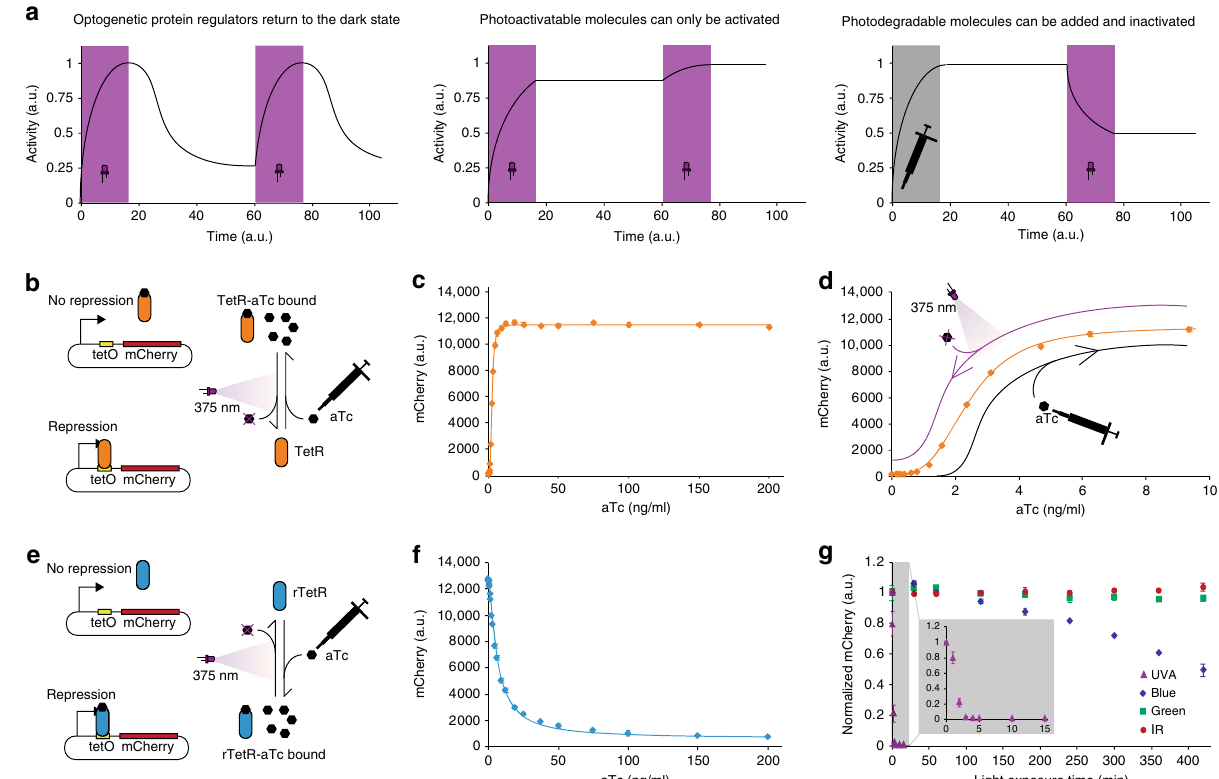
Fig. 1 Photosensitivity of anhydrotetracycline. a Photodegradation of molecules provides the unique feature of single-input setpoint control to increase or decrease the activity of the controlled system in comparison to optogenetic proteins or photoactivatable molecules. TetR (orange diamonds and lines, b – d ) and rTetR (blue diamonds and line, e , f )-controlled expression of mCherry is titratable with aTc ( c , d , f ). b Addition of aTc to cells containing the TetR repressor leads to unbinding from tetO operator sequences allowing transcription from the promoter. No aTc or aTc inactivation allows for TetR binding to tetO and repression of transcription. mCherry was used as a fl uorescent reporter to visualize expression from a TetR-controlled promoter. c Dose – response curve of aTc concentration and mCherry expression for TetR-controlled gene expression and model fi t using Eq. (1). d Dose – response curve as shown in c , zoomed in on the aTc concentration range that is suf fi cient for adjusting the expression level of TetR-controlled gene expression from its minimal to the maximal value. UVA illumination and addition of aTc can be used to change the concentration of aTc in medium containing cells, effectively allowing one to adjust the expression level along the dose – response curve of aTc. e Addition of aTc to cells containing the rTetR repressor, which works opposite to TetR, leads to binding to tetO operator sequences. Accordingly, no aTc or aTc inactivation leaves rTetR unbound from tetO that results in expression of mCherry. f Dose – response curve of aTc concentration and mCherry expression for rTetR-controlled gene expression and model fi t using Eq. (3). g Incubation of medium containing aTc with different wavelengths of light shows fast degradation dynamics with UVA light ( g , gray inset) compared to slow degradation with blue, and no observable degradation with green and infrared light measured through TetR-controlled mCherry expression ( g ). Diagrams show mean mCherry expression values and standard deviation of three biological replicates ( n = 3) measured after 5 h incubation time in all cases. Source data are provided as a Source data fi